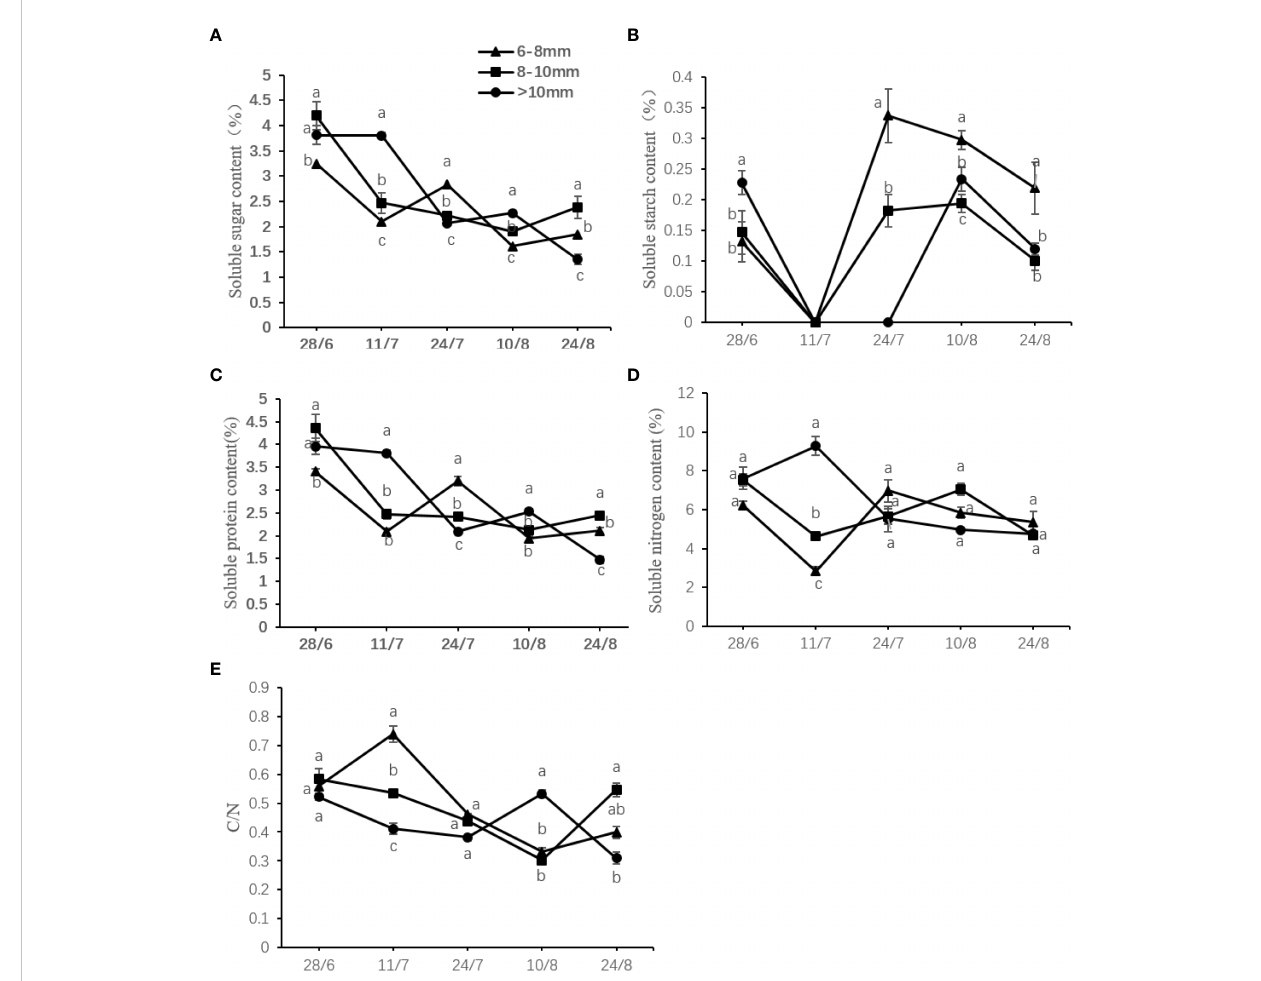
FIGURE 6 Effect of the UST on the (A) soluble sugar content, (B) soluble starch content, (C) soluble carbon content, (D) soluble protein content, and (E) C/N ratio in the bud on upper canopy. The lower-case letters represented signi fi cant difference ( P <